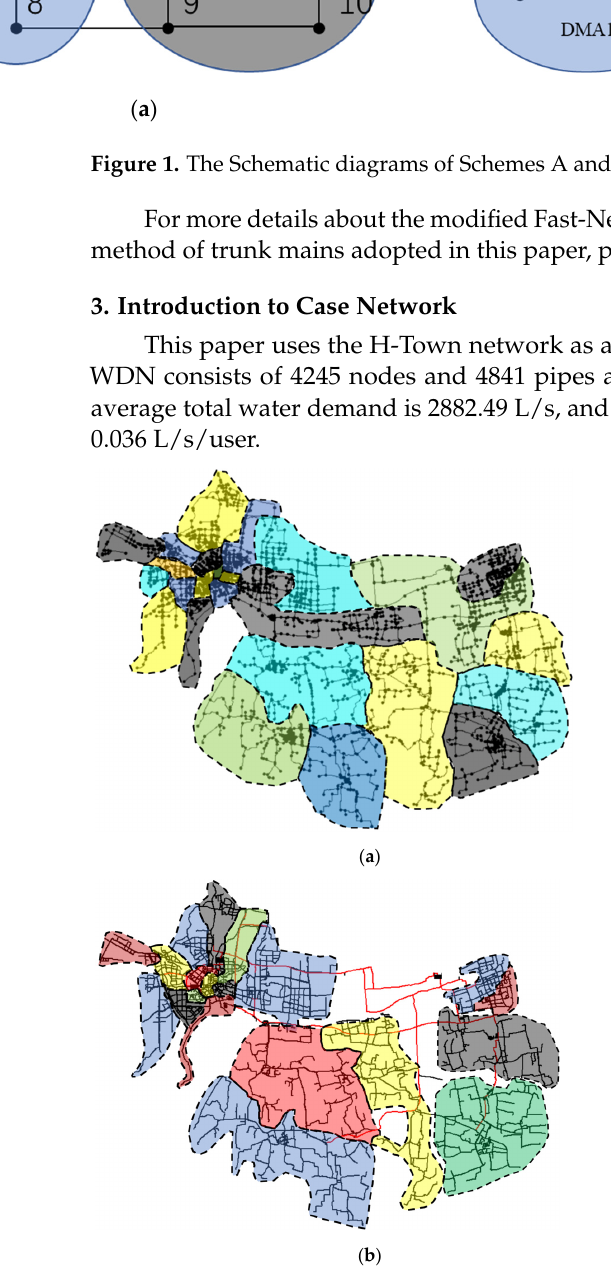
Figure 2. H ‐ Town partitioning schemes: ( a ) Scheme A and ( b ) Scheme B. Figure 2. H-Town partitioning schemes: ( a ) Scheme A and ( b ) Scheme